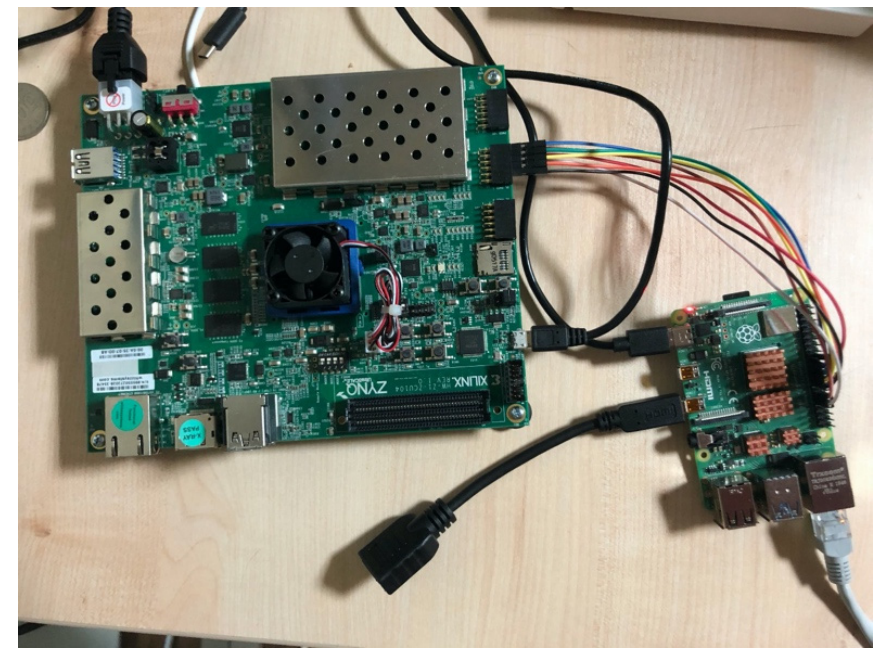
Figure 15. Environment of simulation using hardware (FPGA board).